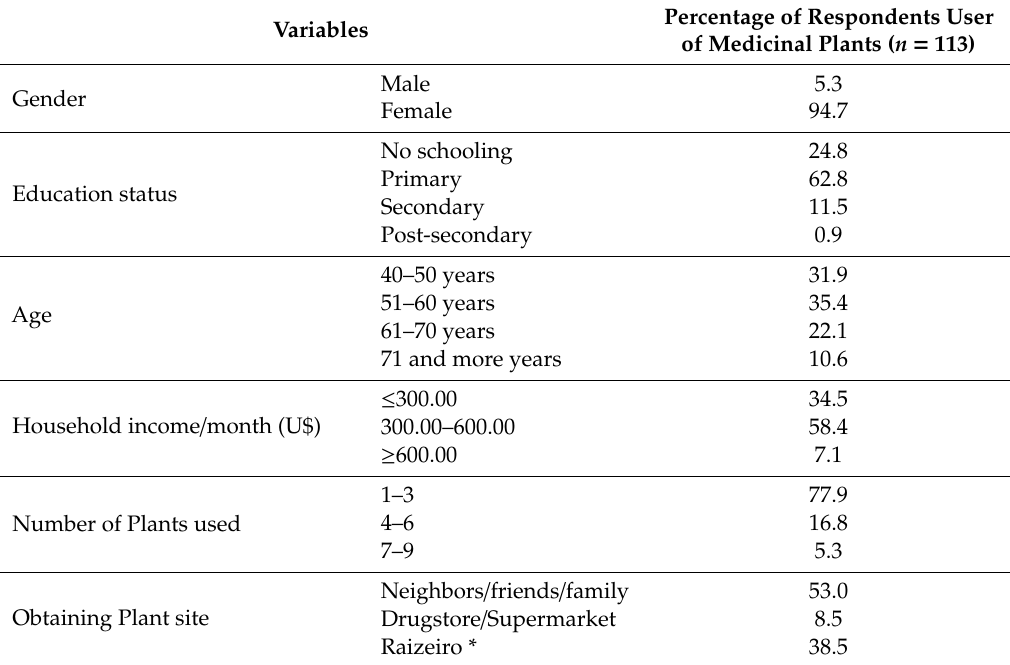
Table 1. Socio-economic characteristic of the respondents. Variables